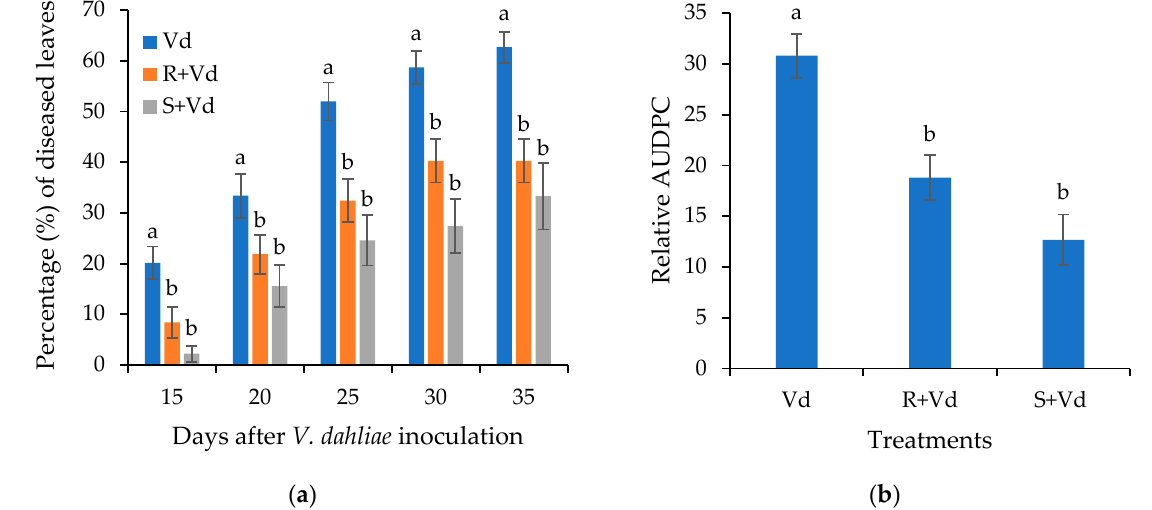
Figure 3. Verticillium disease severity ( a ) and relative AUDPC ( b ) caused by artificial inoculation of V. dahliae (Vd), on eggplants stem injected (S + Vd) or root drenched (R + Vd) with autoclaved spores of V. dahliae or mock inoculated (positive control, Vd). Columns represent means of three replications per treatment ( n = 30 plants, ± SE). Different letters denote statistically significant differences between treatments ( p < 0.05) according to LSD test. For disease severity, statistics were performed at each time point.